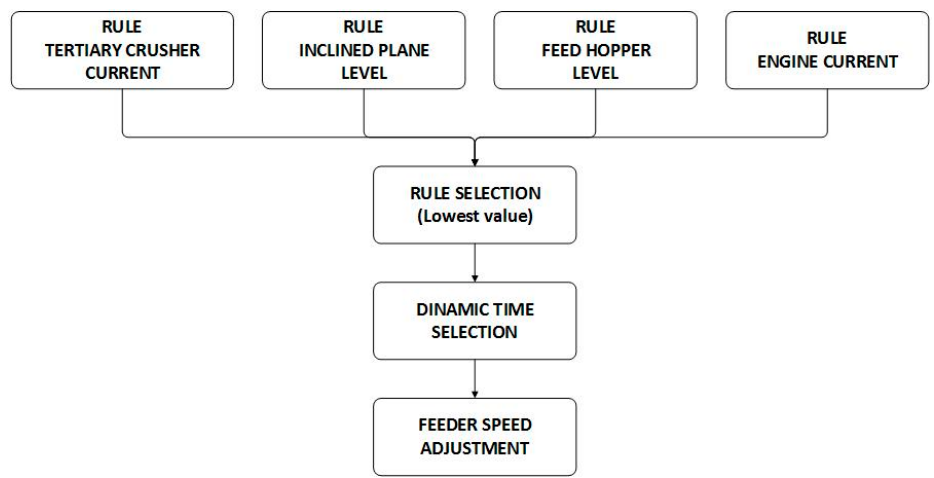
Figure 2. Expert system K-UCN—tertiary crusher. Table 3. Established Operational Ranges: Tertiary Crusher Line 1, Expert System K-UCN.